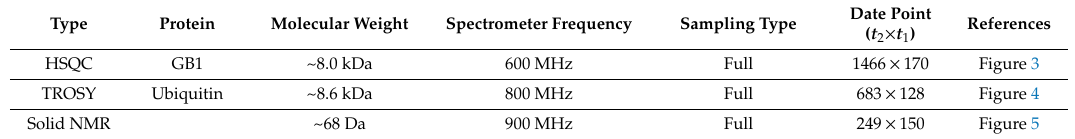
Figure 5. Reconstructed solid NMR spectra with 15% NUS data. ( a ) The fully sampled spectrum; ( b – e ) reconstructed spectra using the LRHM, LRHMF, SLS, and SLSMF, respectively. Note: The contours of spectra are at the same level. Table 2. Important parameters of experimental 2D